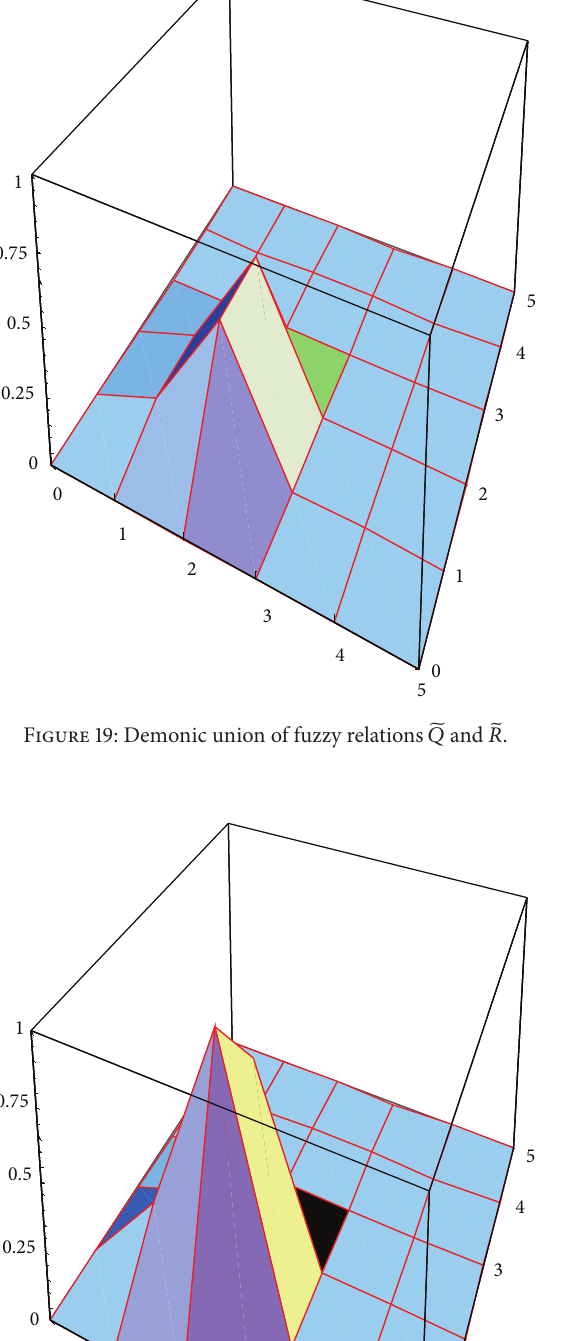
Figure 22: Angelic intersection of fuzzy relations